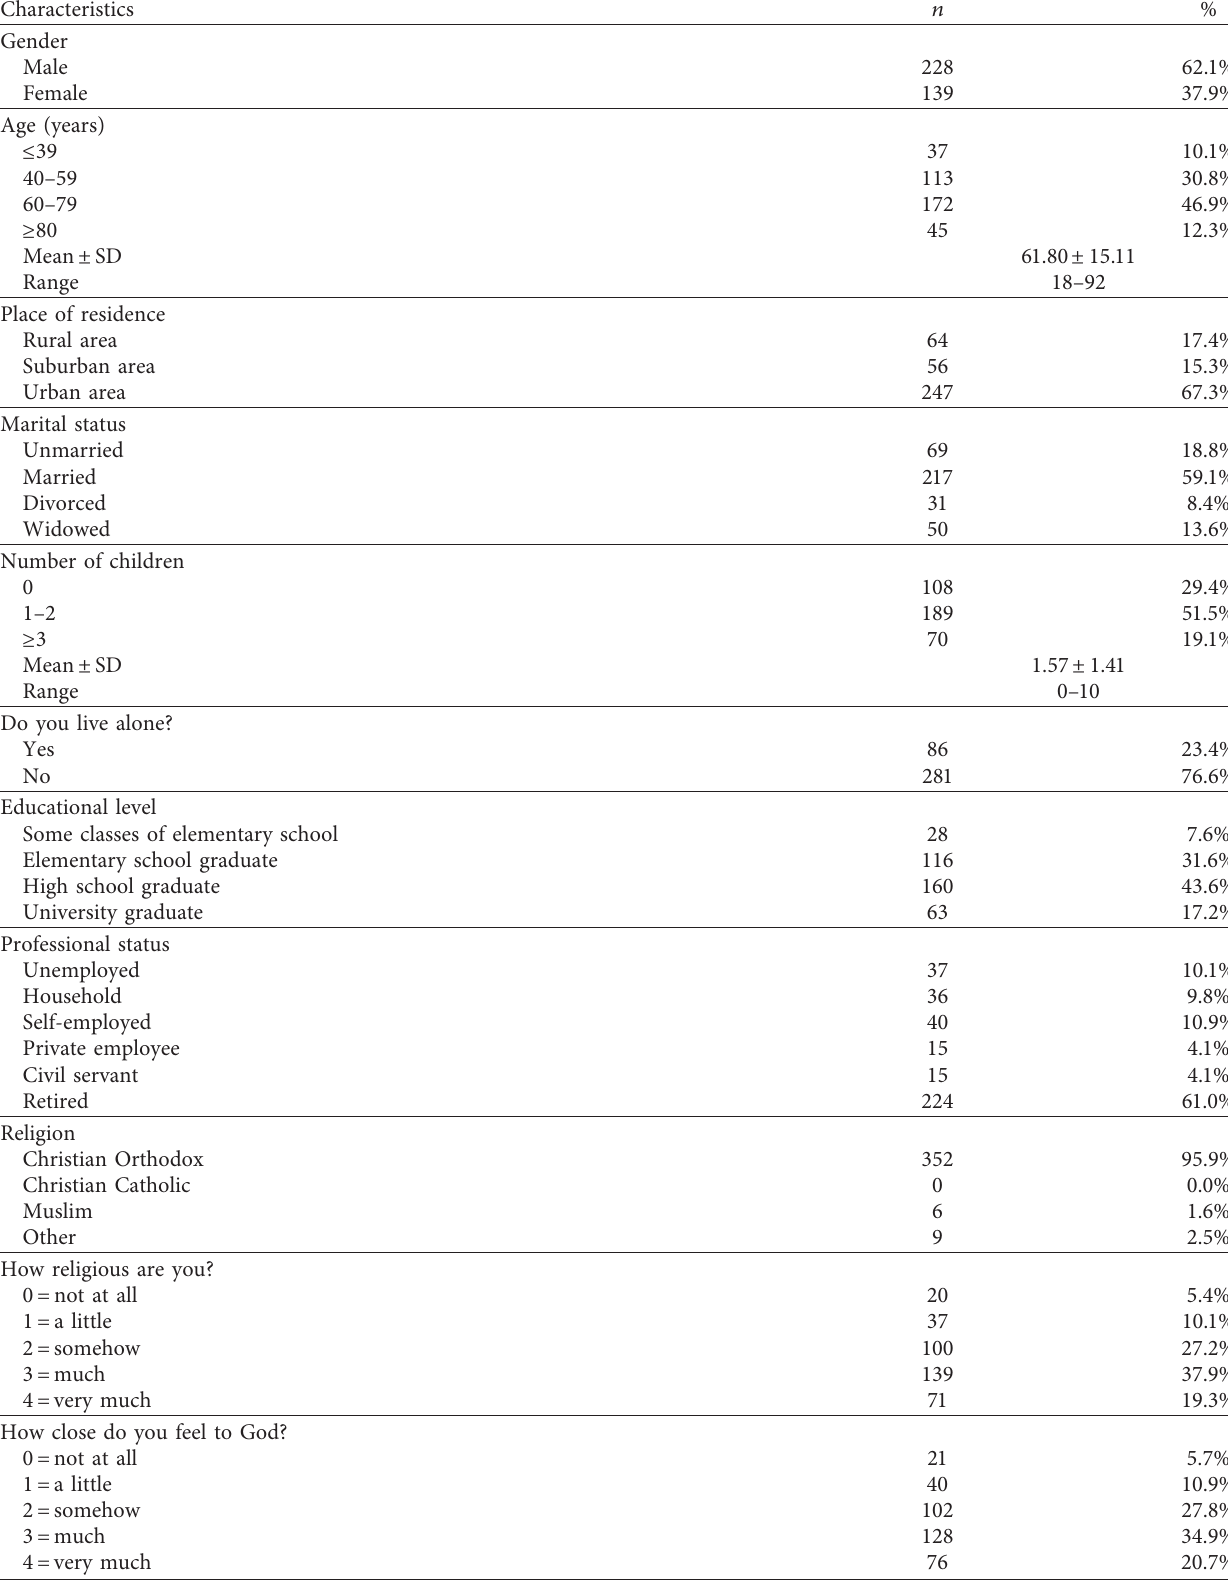
Table 1: Characteristics of the sample ( n �